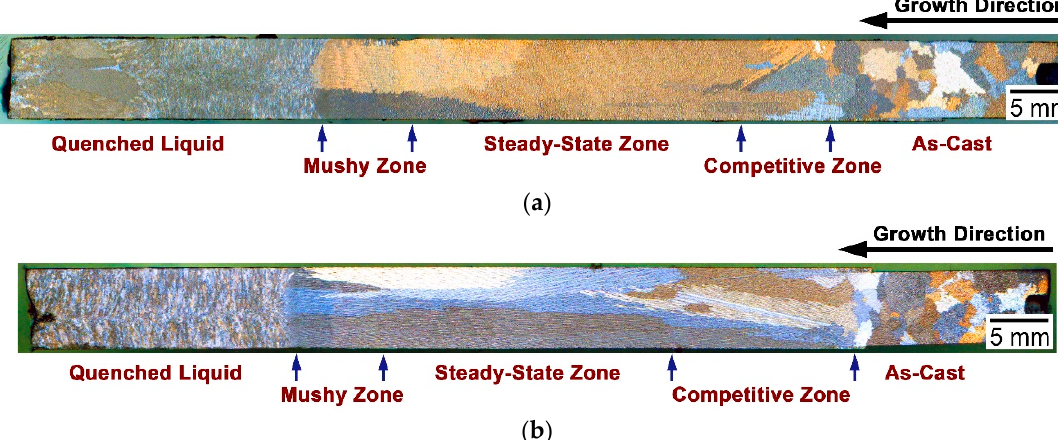
Figure 5. Optical images of longitudinal macro-grain structures in as-cast alloy 3C2N after the LMC- DS processing under different withdraw rates: ( a ) 20 and ( b ) 50 (cid:912)